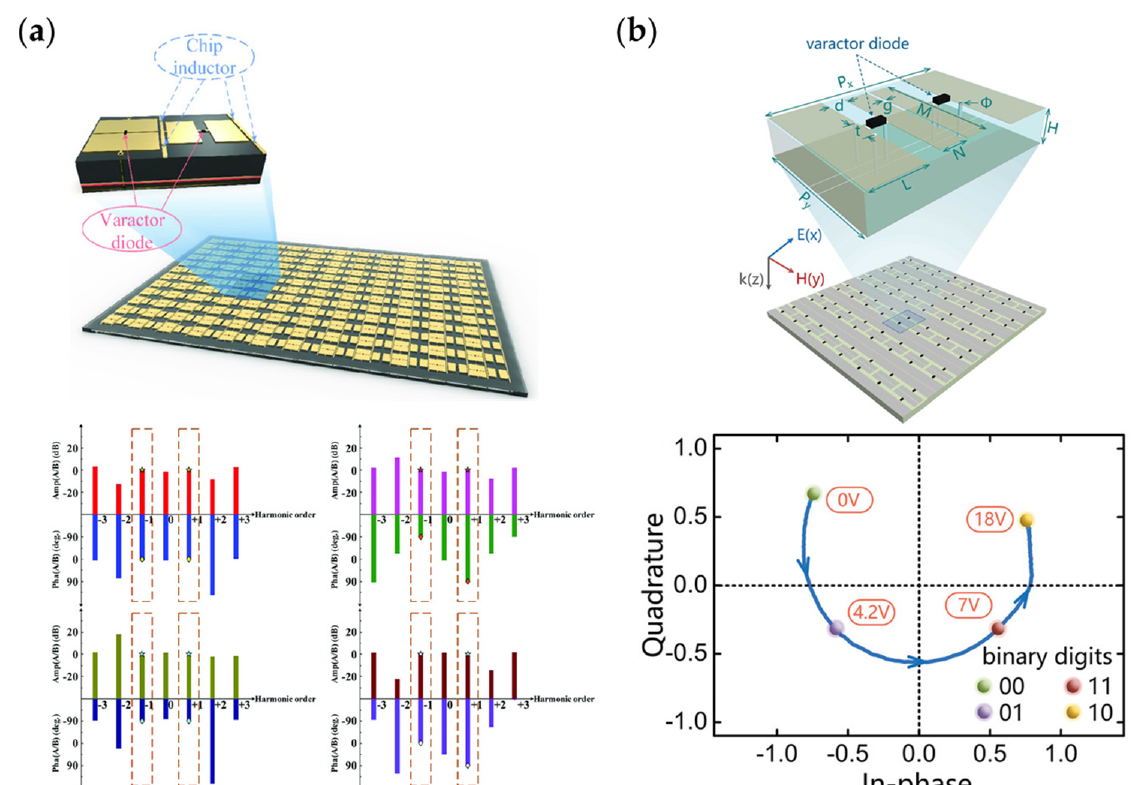
Figure 11. ( a ) Space-time modulation meta to achieve symmetrical or asymmetrical phase